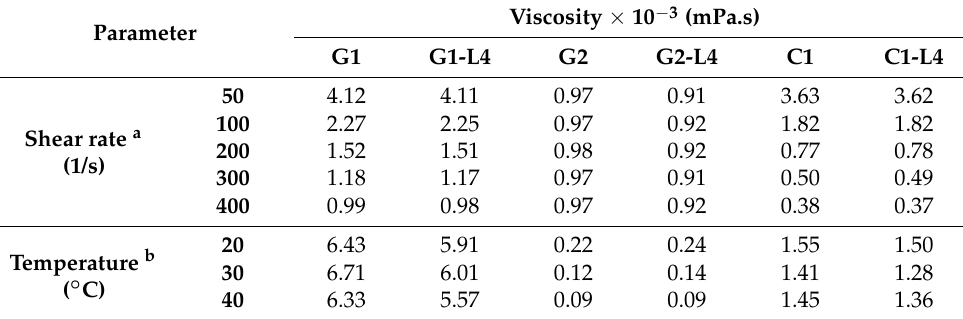
Table 1. Apparent viscosity values as a function of shear rate and temperature.